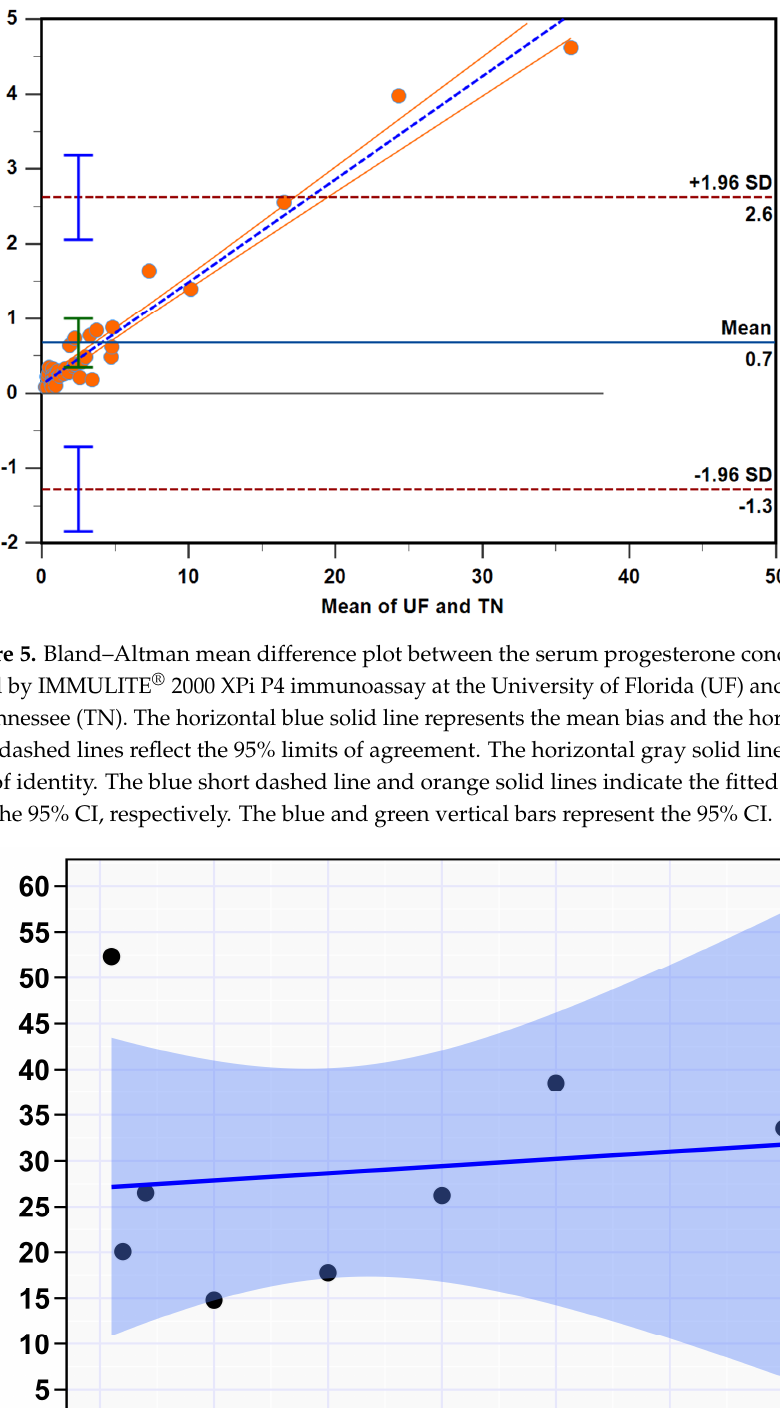
Figure 4. Scatterplot indicating the relationship between the serum progesterone concentration meas- ured by the IMMULITE ® 2000 XPi P4 immunoassay at the University of Florida (UF) and the Univer- sity of Tennessee (TN). The grey dashed diagonal line is the line of identity, and the solid blue line is the line of best fit from Passing–Bablok.